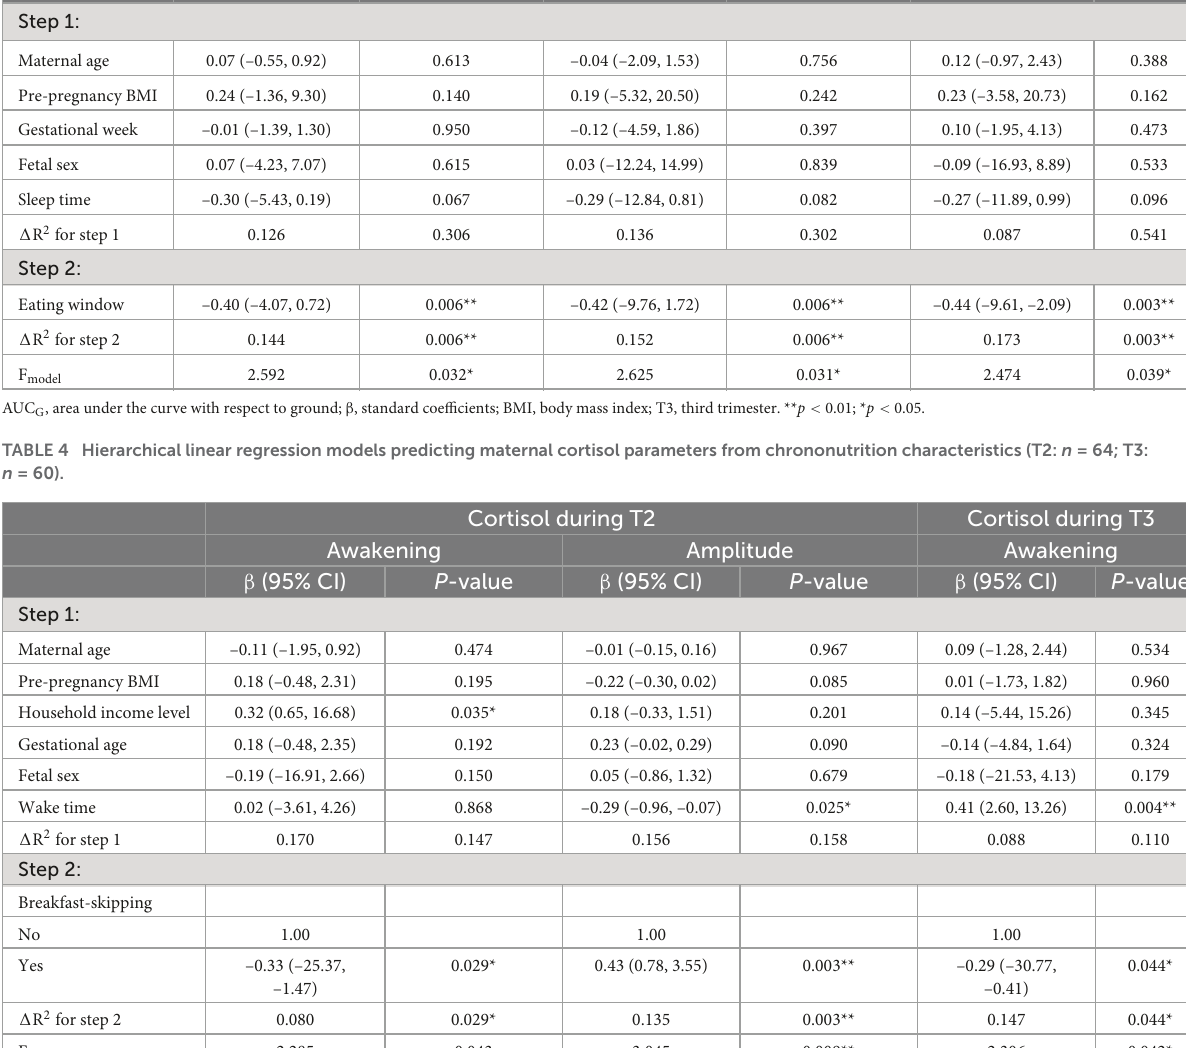
Melatonin during T3